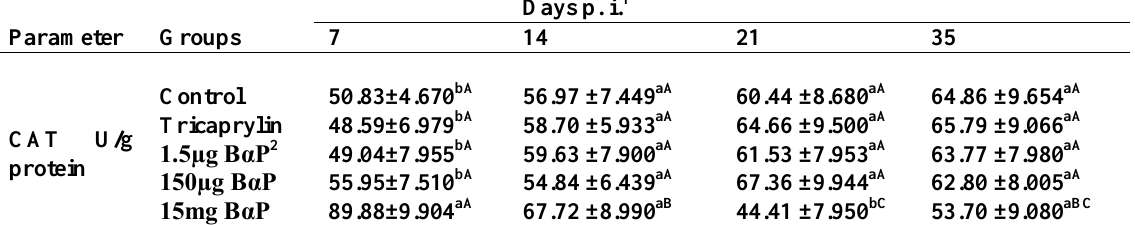
Table )4): Changes in catalase (CAT) activity (U/g protein) in liver tissue homogenate (mean ± SD) of broiler males treated with